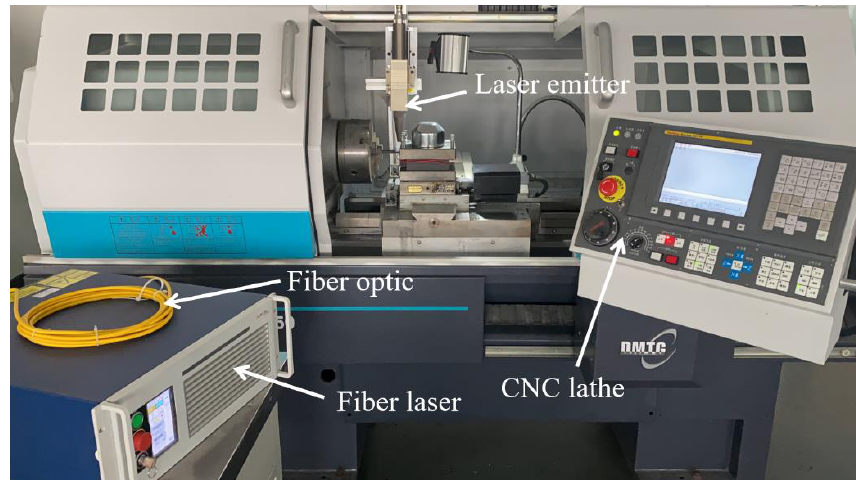
Figure 1. Laser-assisted turning equipment.